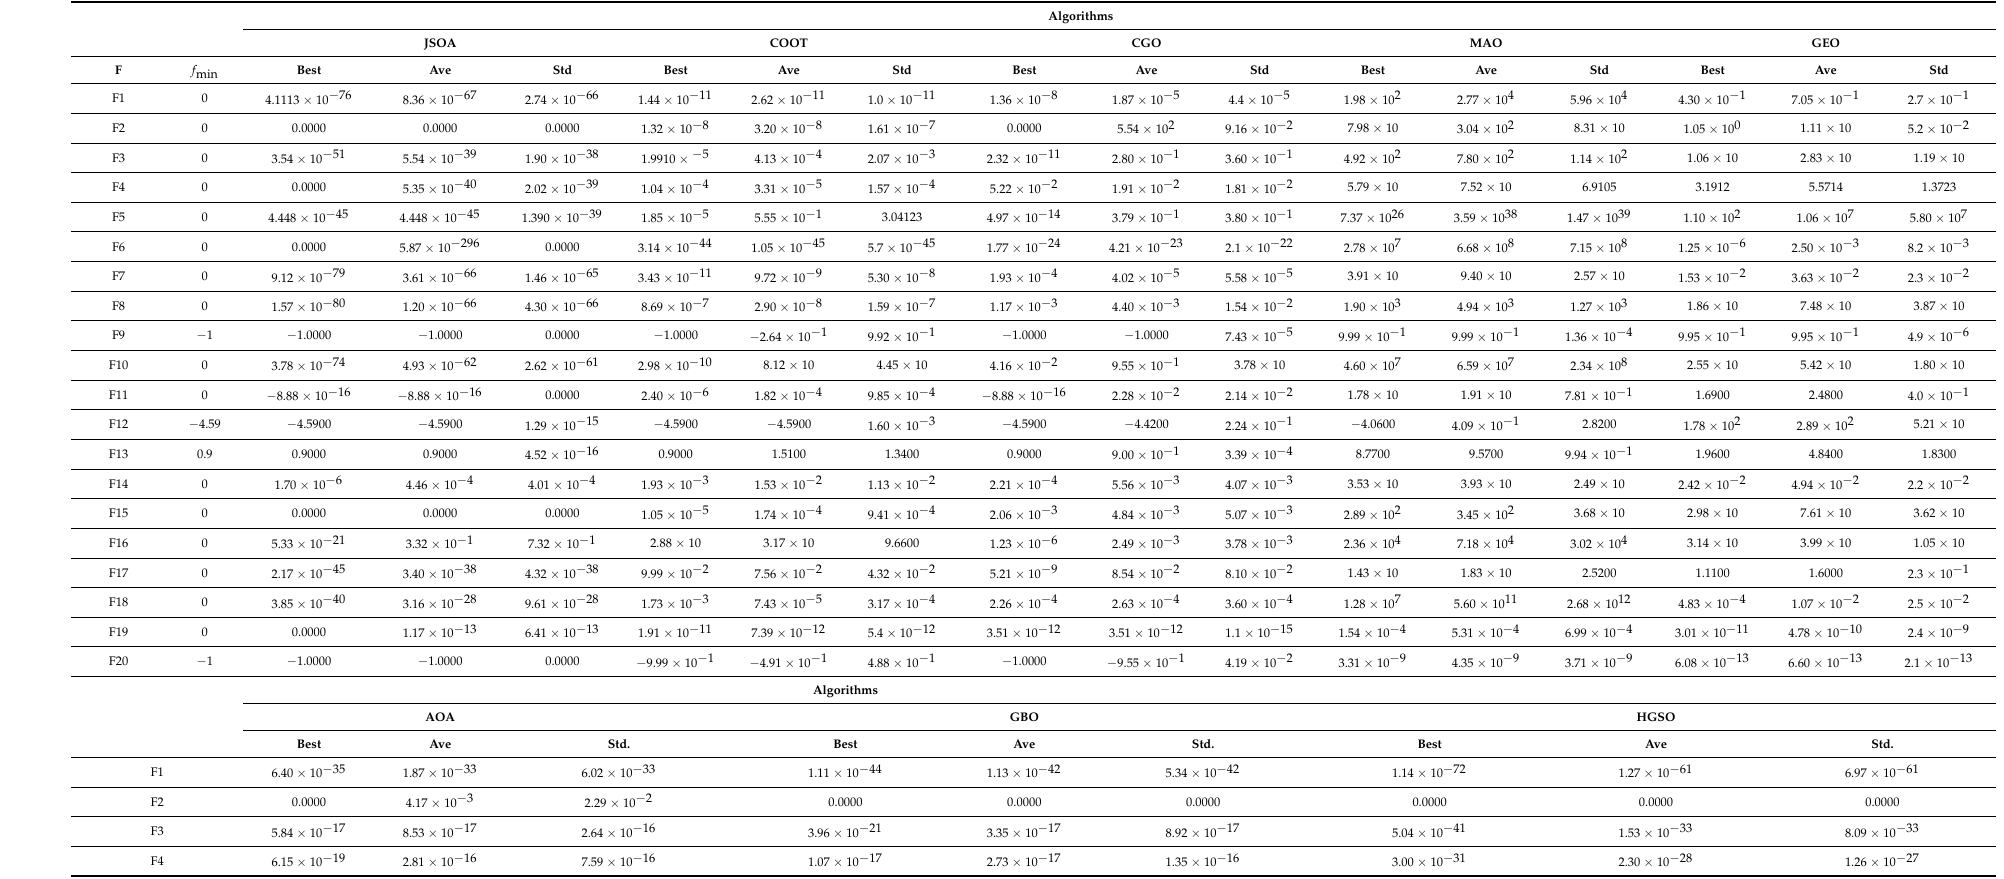
Table 2. JSOA—Performance and